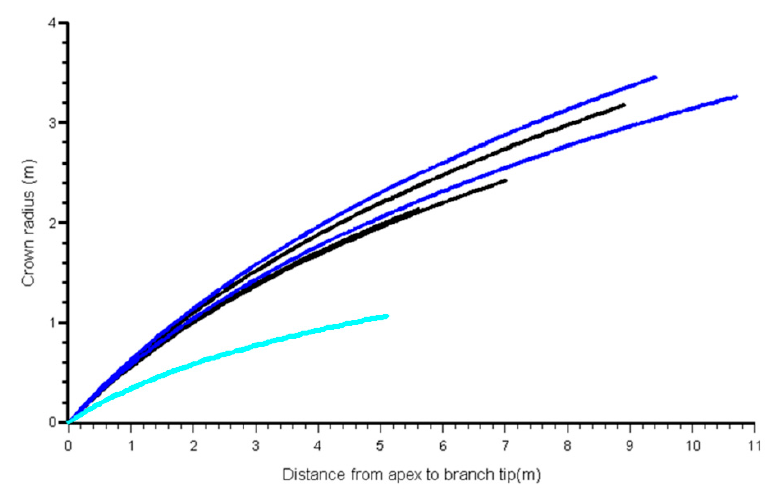
Figure 4. Predicted western hemlock crown profiles from MB0 model, from apex to point of crown contact, within four selected stands showing variation in social status: ( a ) 60-year age class at Franklin River (G86), ( b ) 60-year age class at Port McNeil (W98), ( c ) 20 year age class at Port Renfrew (W98) and ( d ) 40 year age class at Port Renfrew (W98). Green = Open-grown, Blue = Dominant, Black = Co-dominant, Cyan = Intermediate, Red = Suppressed. Note that not all stands had all social status categories.